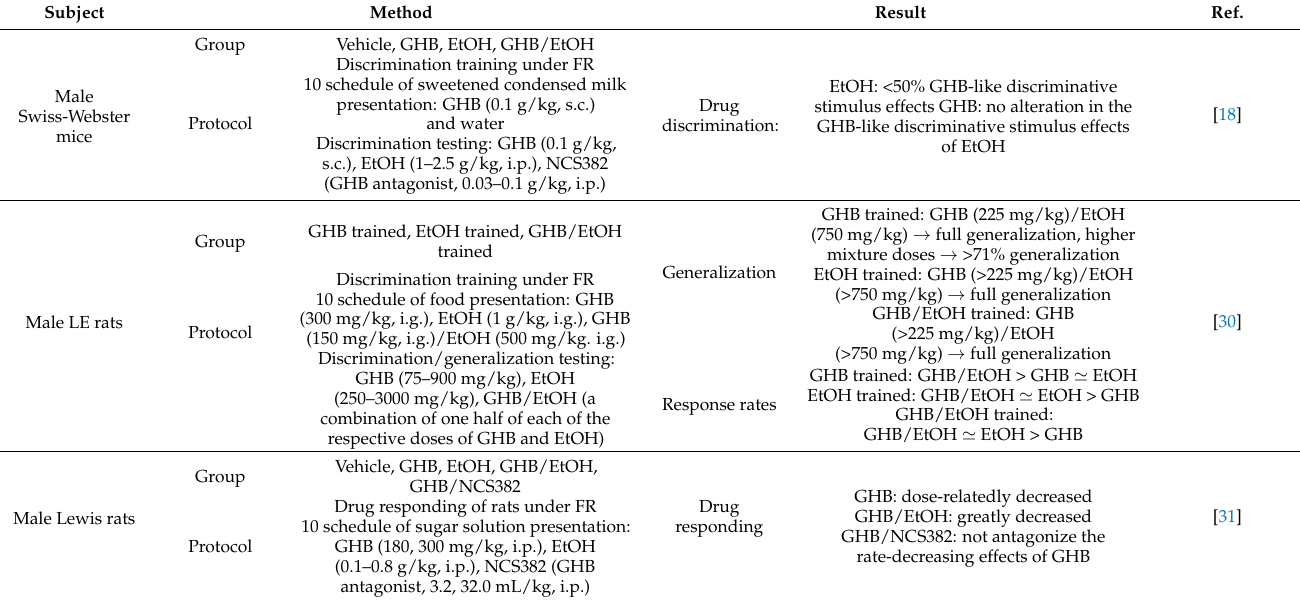
Table 5. Drug discrimination or response following gamma-hydroxybutyric acid (GHB) and ethanol